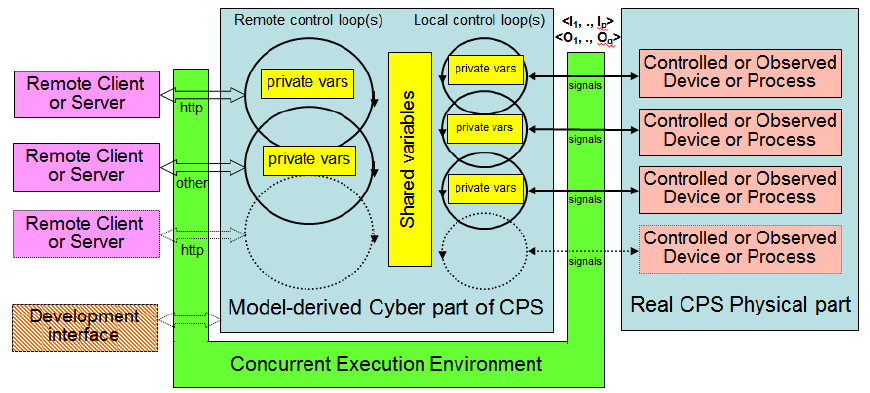
Figure 1. Reference architecture for Model-Based designed CPS.